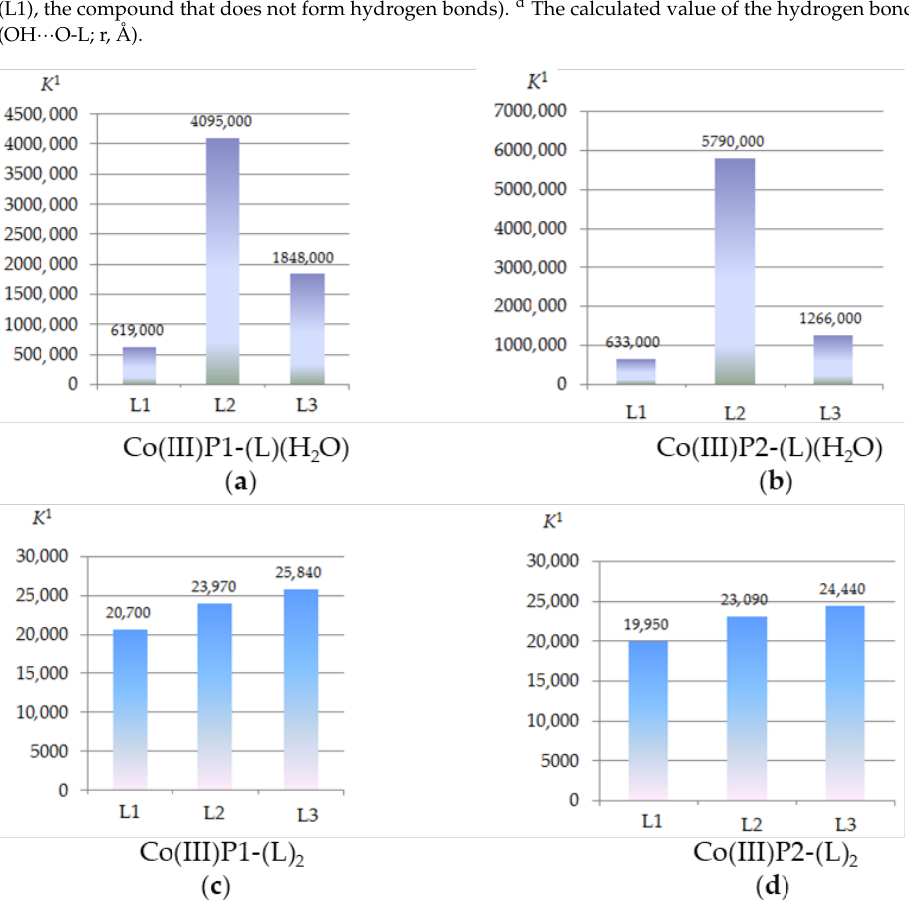
Figure 3. Stability constants ( K 1 and K 2 , (M –1 ) of the mono- and bis -axial complexes Co(III)P(1-2)- (L)(H 2 O) and Co(III)P(1-2)-(L) 2 , phosphate buffer (pH 7.4) at 25 °С.